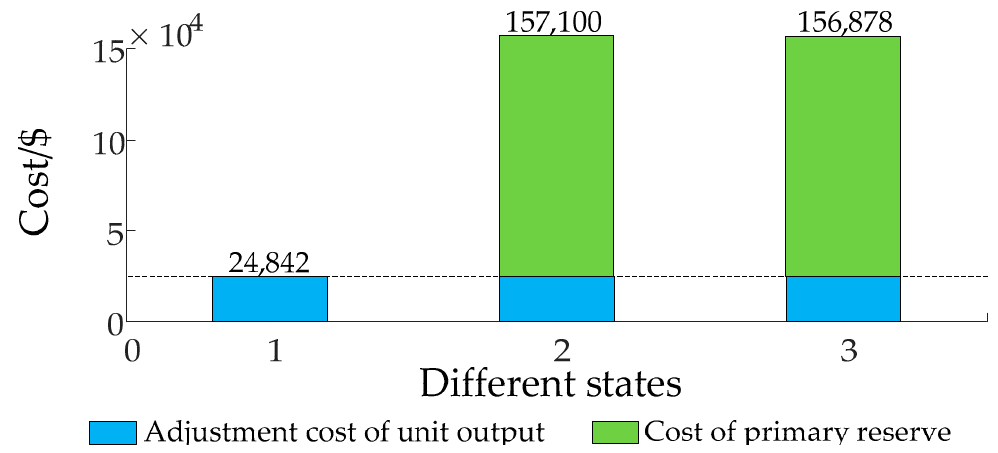
Figure 5. Classification of real-time operating costs.